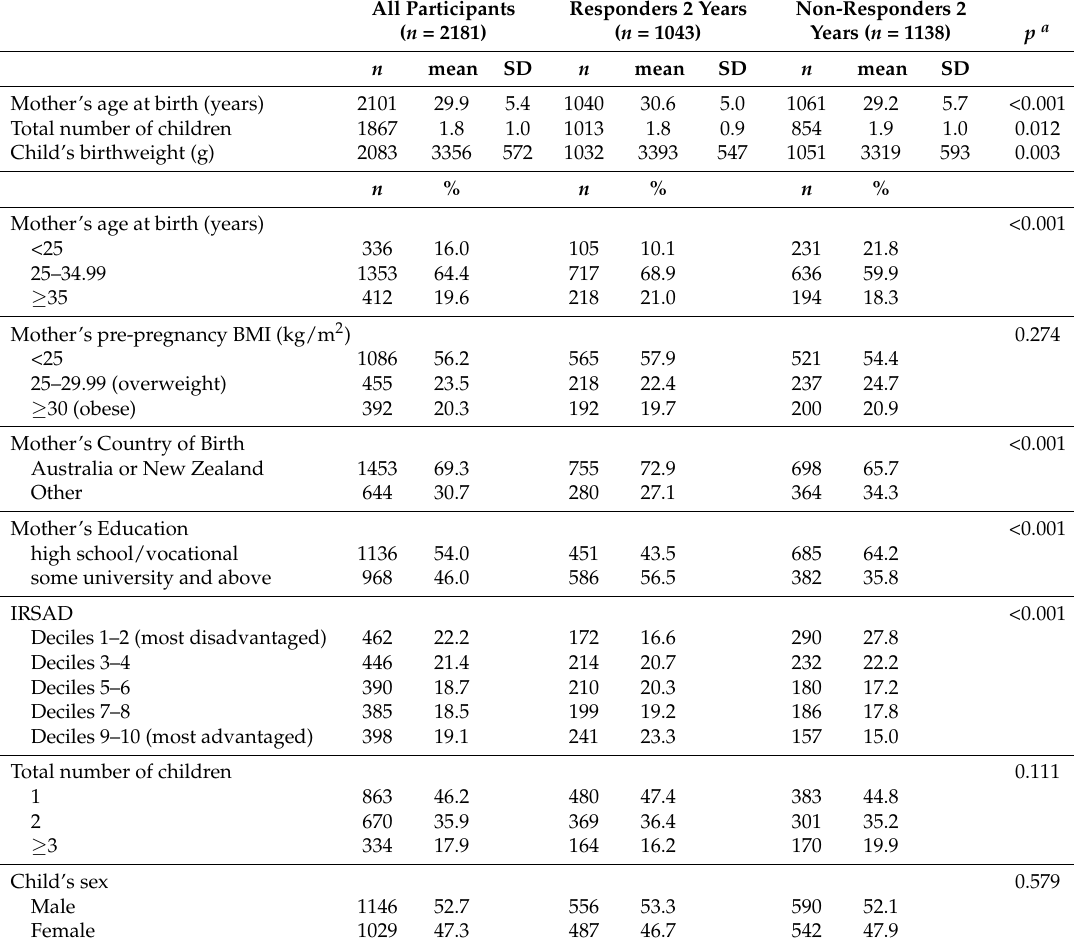
Table 1. Participant characteristics.